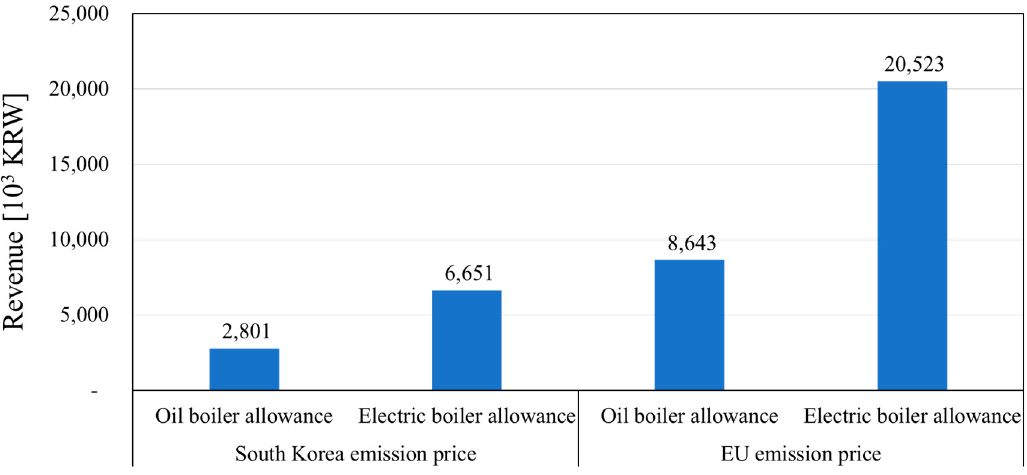
Figure 9. Revenue of greenhouse gas emission trading.